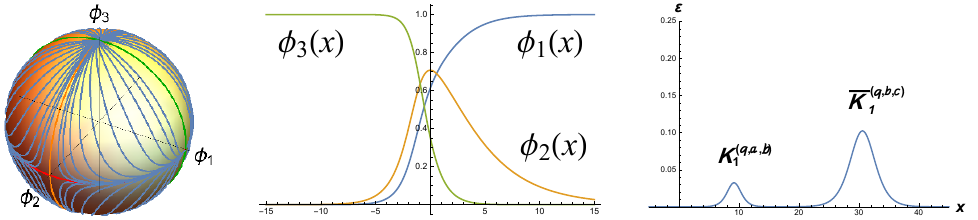
Figure 5 . Orbits for several members of the family K ( q;a;b;c ) and wall tension densities (right) graphically represented in Cartesian